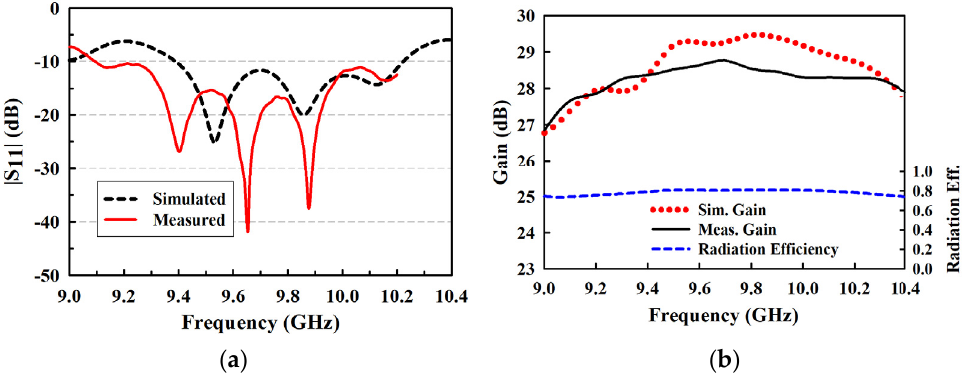
Figure 11. Experimental results of the proposed 12 × 16 planar array antenna. ( a ) S 11; ( b ) gain and efficiency.